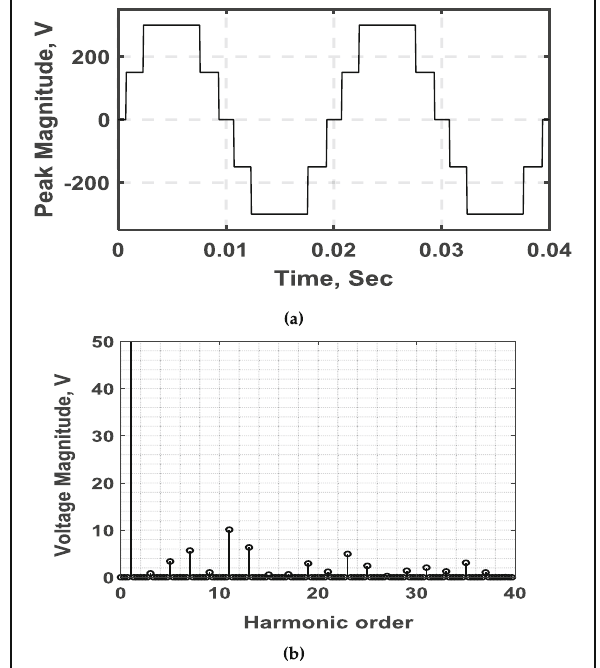
Fig. 5 Simulation results of a five level inverter by optimization technique. a Output voltage waveform. b Order of